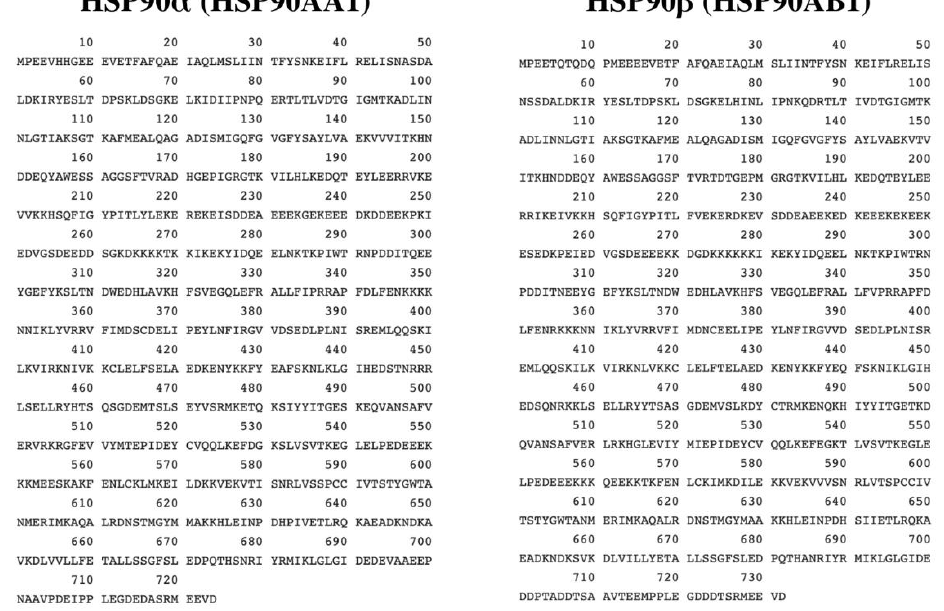
Figure 1. The amino acid sequences of isoforms HSP90α (HSP90AA1) and HSP90β (HSP90AB1)